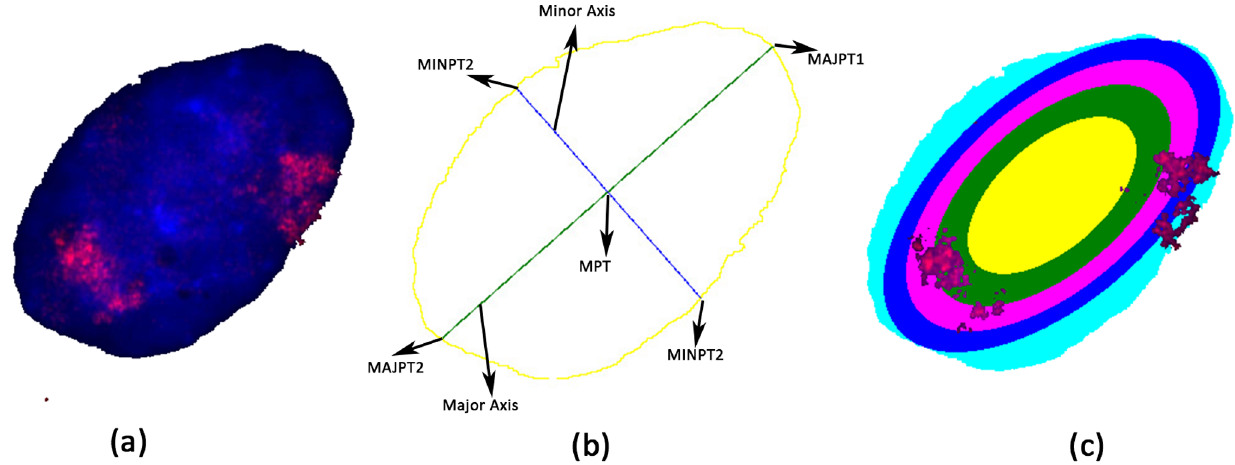
Figure 3. Steps in quantifying chromosome localization: (a) The original image obtained from two-dimensional fluorescence in situ hybridization (FISH). The background, cytoplasm and chromosome are colored white, blue and red respectively. (b) The contour is colored yellow, while the major and minor axes are in green and blue respectively. (c) The nucleus is partitioned into five concentric shells of equal area, and the percentages of chromosome in each shell are computed using the number of red pixels (Table 1).